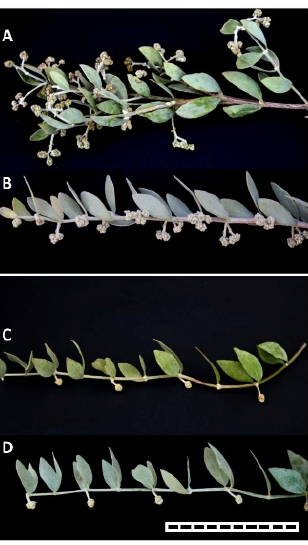
Figure 1. Inflorescence density in ( A , B ) selected male genotypes and ( C , D ) regular lines with low performances. Bar: 10 cm.